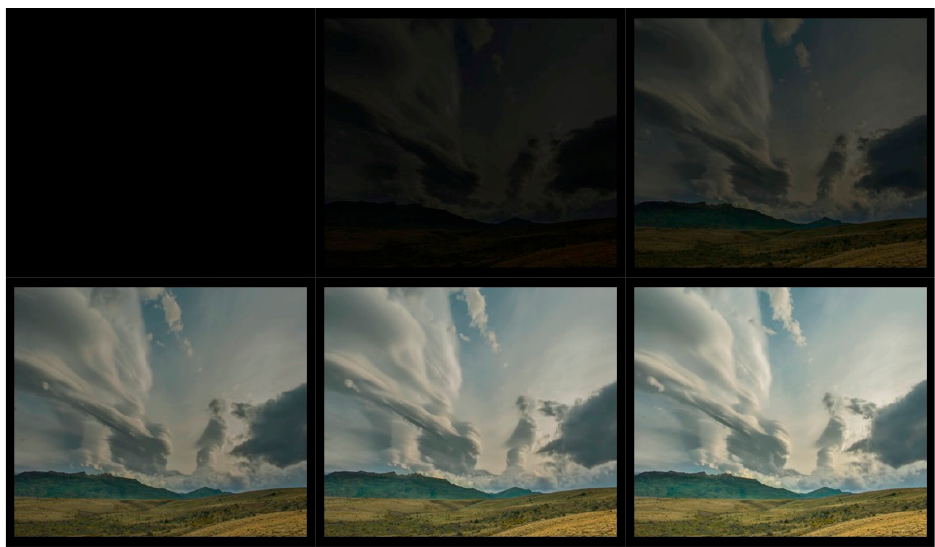
Figure 4. A preview of the frames from the test video used for the research presentation is subse- quently (from the top left): 1, 5, 10, 20, 25, and 30.